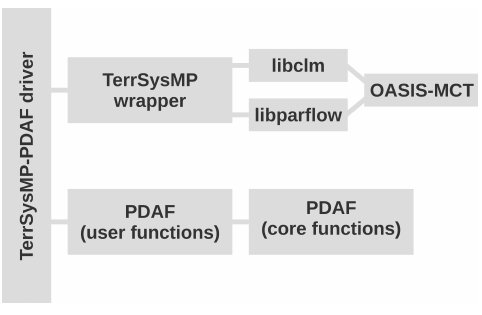
Figure 3. Components of